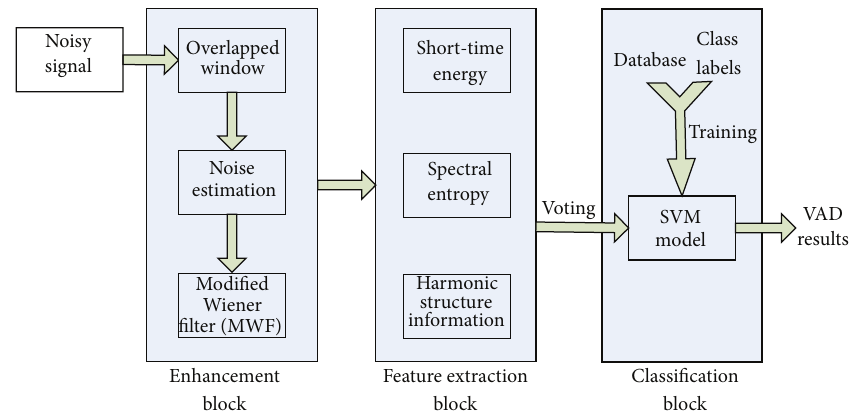
Figure 1: Hierarchical framework of proposed system.